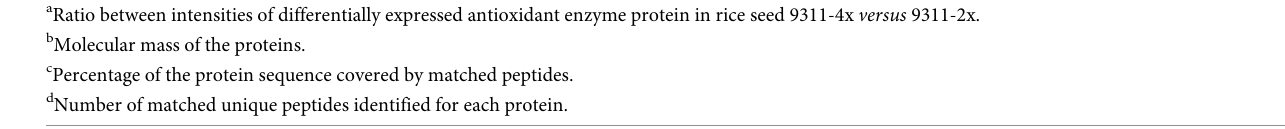
XP_015646556.1 L-ascorbate peroxidase 2, cytosolic [Oryza sativa Japonica Group]